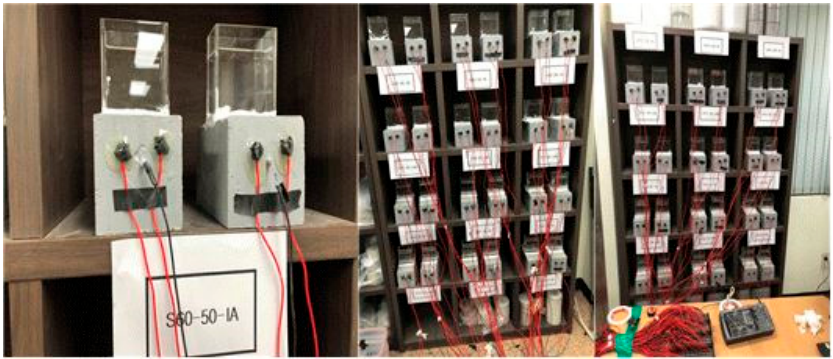
Figure 5. Photograph image of potential monitoring experiment.